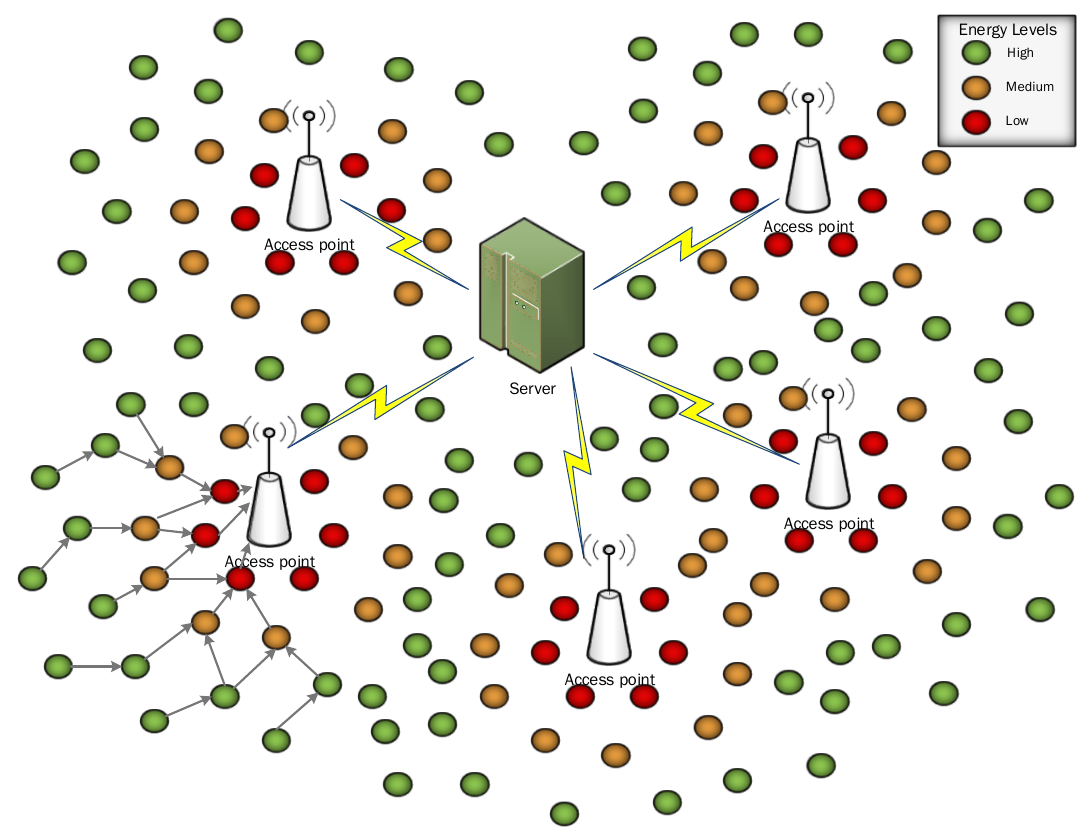
Figure 2. The energy-wave problem in sensor network